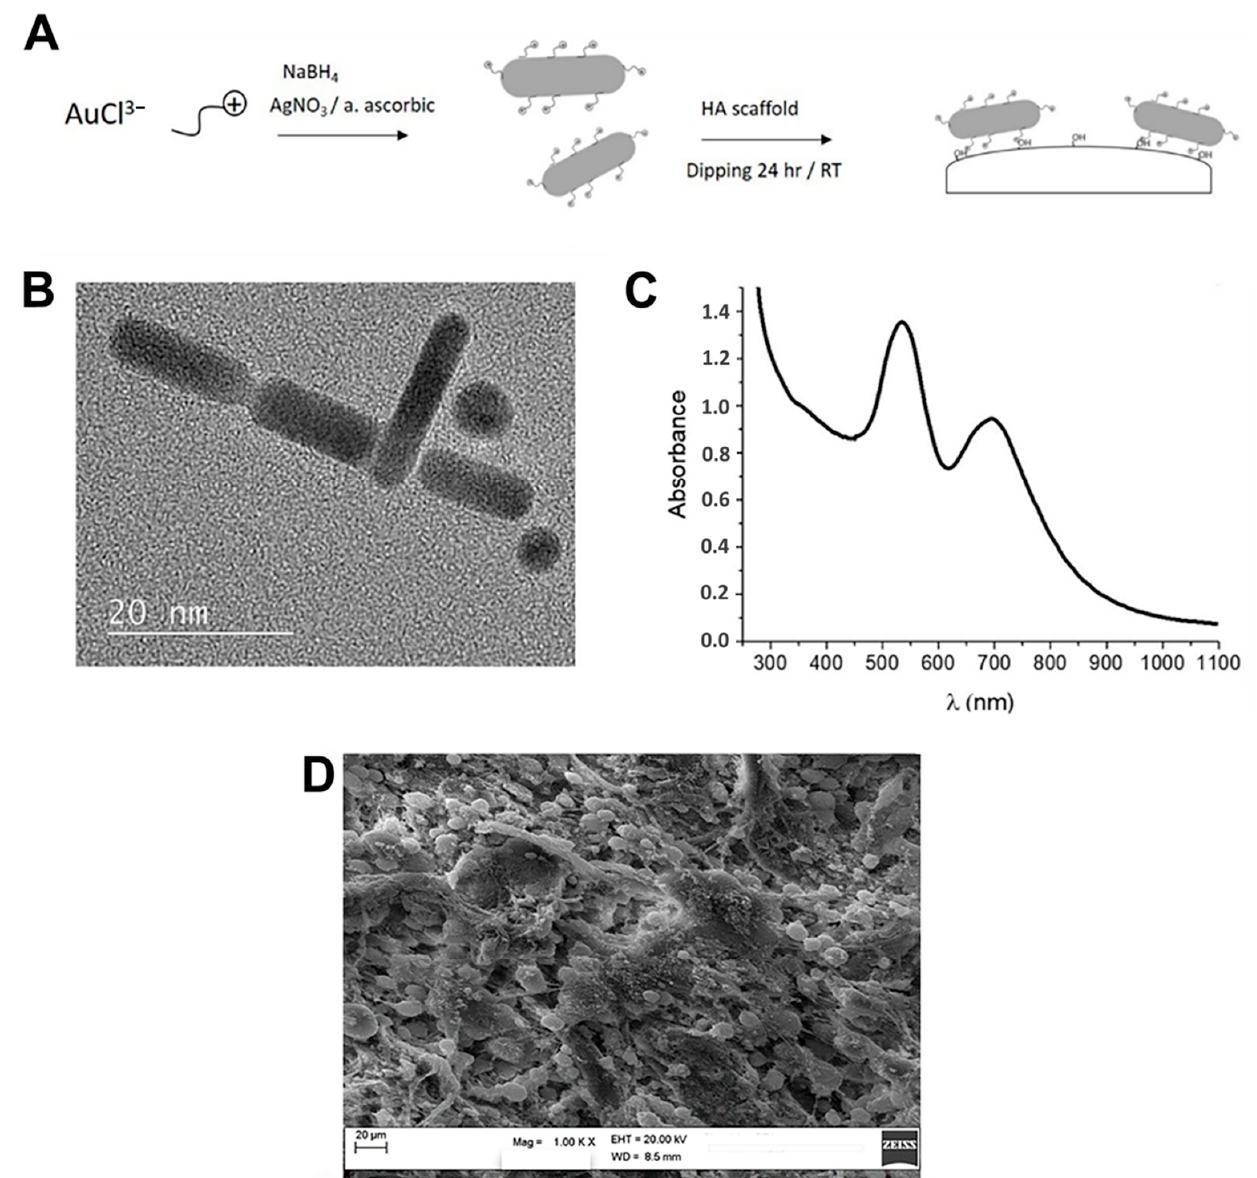
Figure 1. ( A ) Schematic reaction steps of AuNR_MgHA scaffold preparation; ( B ) Representative transmission electron microscopy (TEM) image of AuNR nanostructures; ( C ) UV optical absorption spectrum of AuNR dispersion; ( D ) SEM image of AuNR_MgHA scaffold. Magnification 1000×.